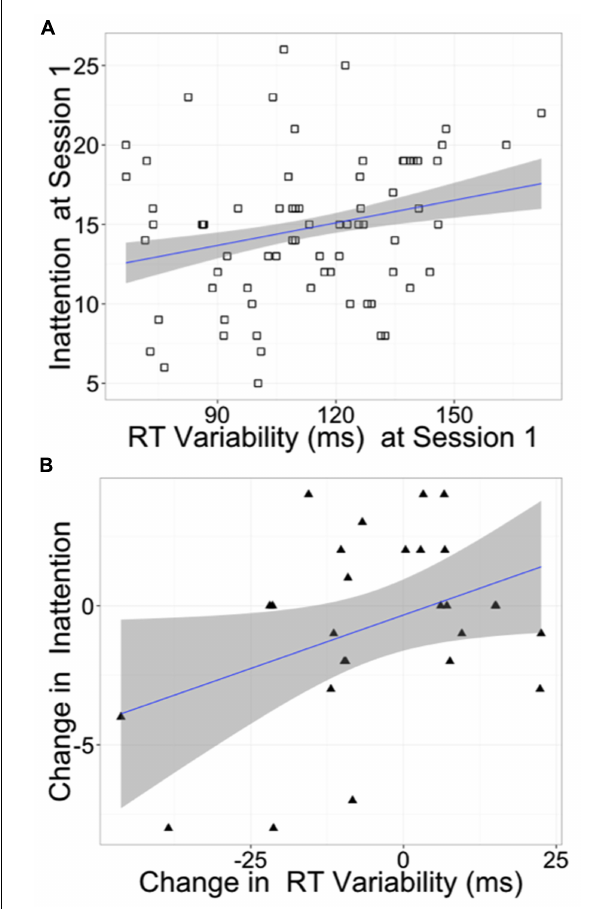
FIGURE 3 | Inattention and reaction time variability. (A) At baseline, inattention correlated with reaction time variability in the affective go/no-go task across all subjects [ r (72) = 0.251, p = 0.034], and (B) improvements in attention correlated with reductions in reaction time variability across the tai chi subjects [ r (27) = 0.387, p = 0.046]. Change from session 1 to session 3. Inattention: ASRS inattention items 1–9. ReactionTime